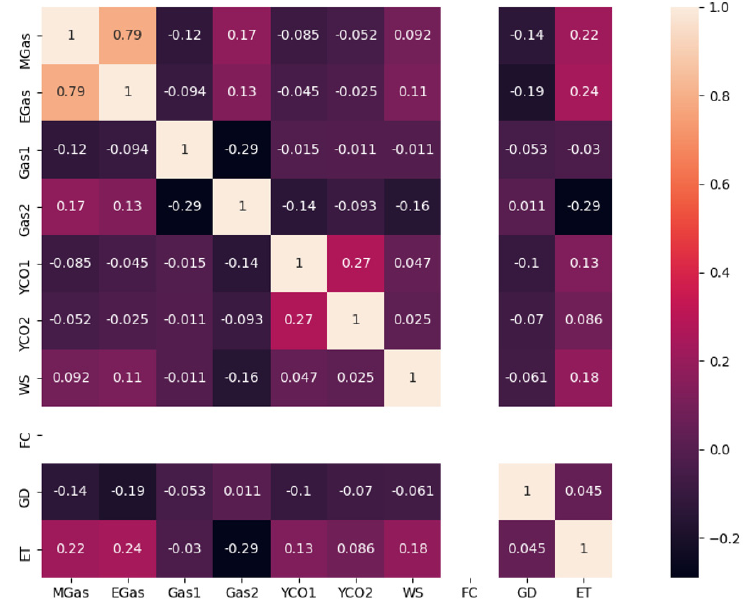
Figure 4. Correlation analysis of data.